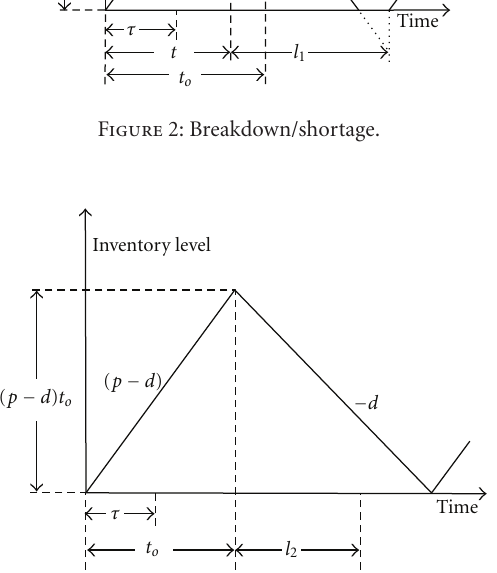
Figure 3: No Breakdown/no